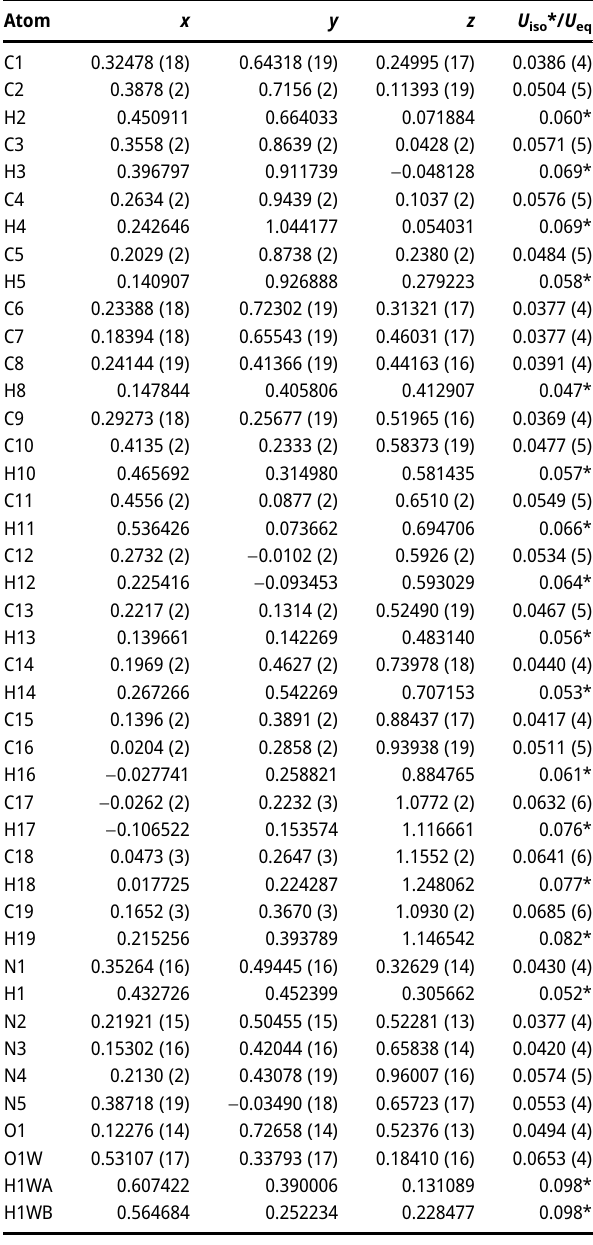
Table  : Fractional atomic coordinates and isotropic or equivalent isotropic displacement parameters (Å 